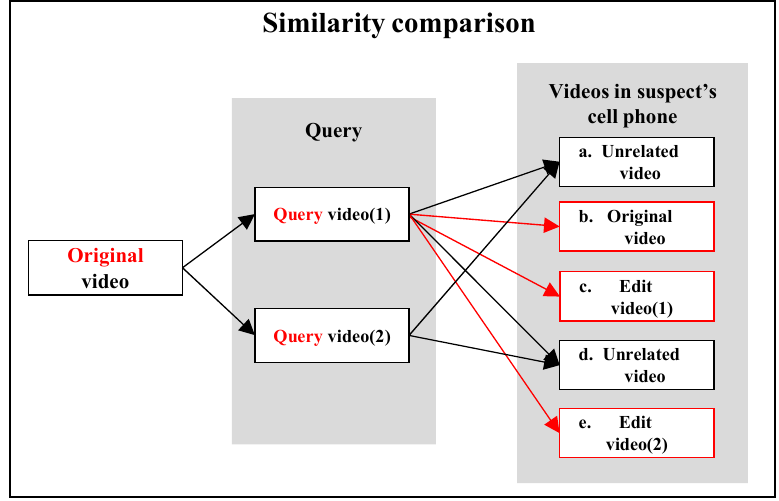
Figure 9. Comparison in scenario 2.